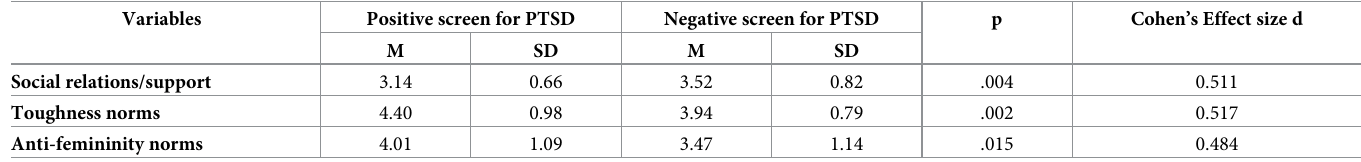
Table 5. Results of the Mann–Whitney U test–intergroup differences in perceived social support and male role norms between the groups with the positive screen for PTSD and the negative screen for PTSD.